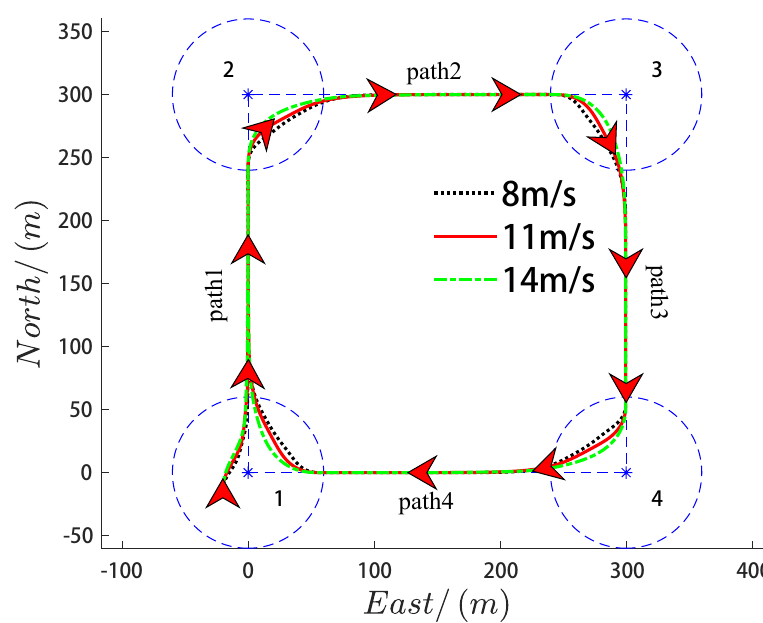
Figure 11. The flight path of the full-wing drone when tracking a four-sided path.